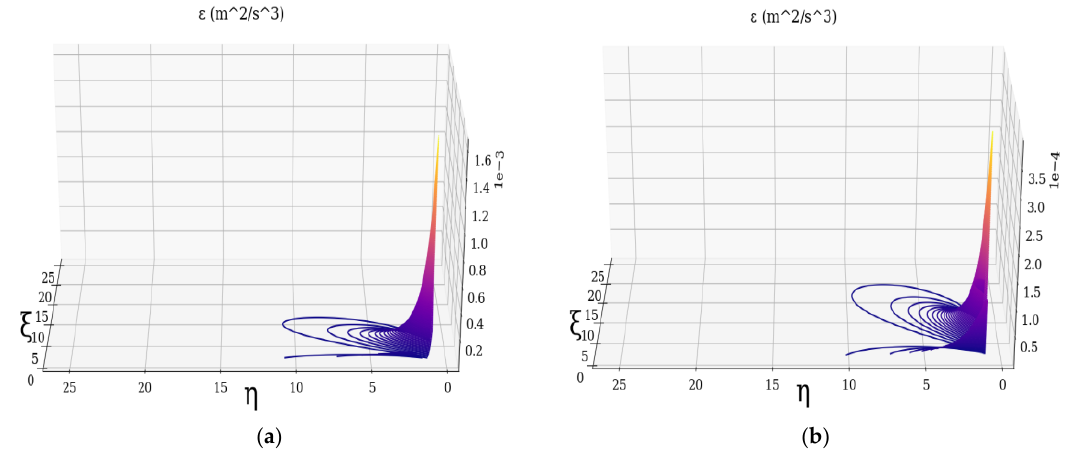
Figure 5. Turbulent dissipation field of minimal vortex of the non-differentiable atmospheric multifractal: ( a ) ν = 0.5, ( b ) ν = 1.5.